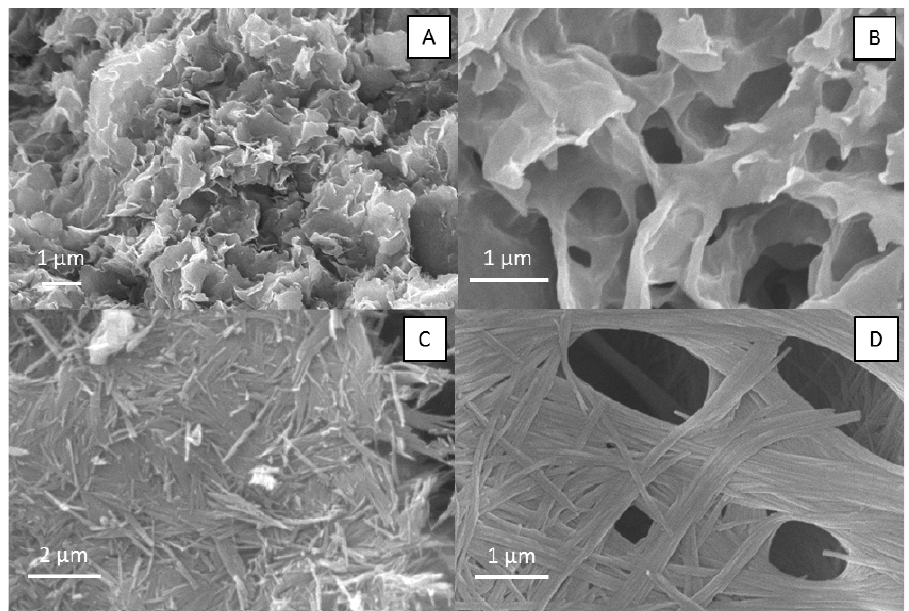
Figure 2. SEM images of Al-bearing and Al-free Mg-clay minerals. ( A ) Saponite. ( B ) Stevensite. ( C )